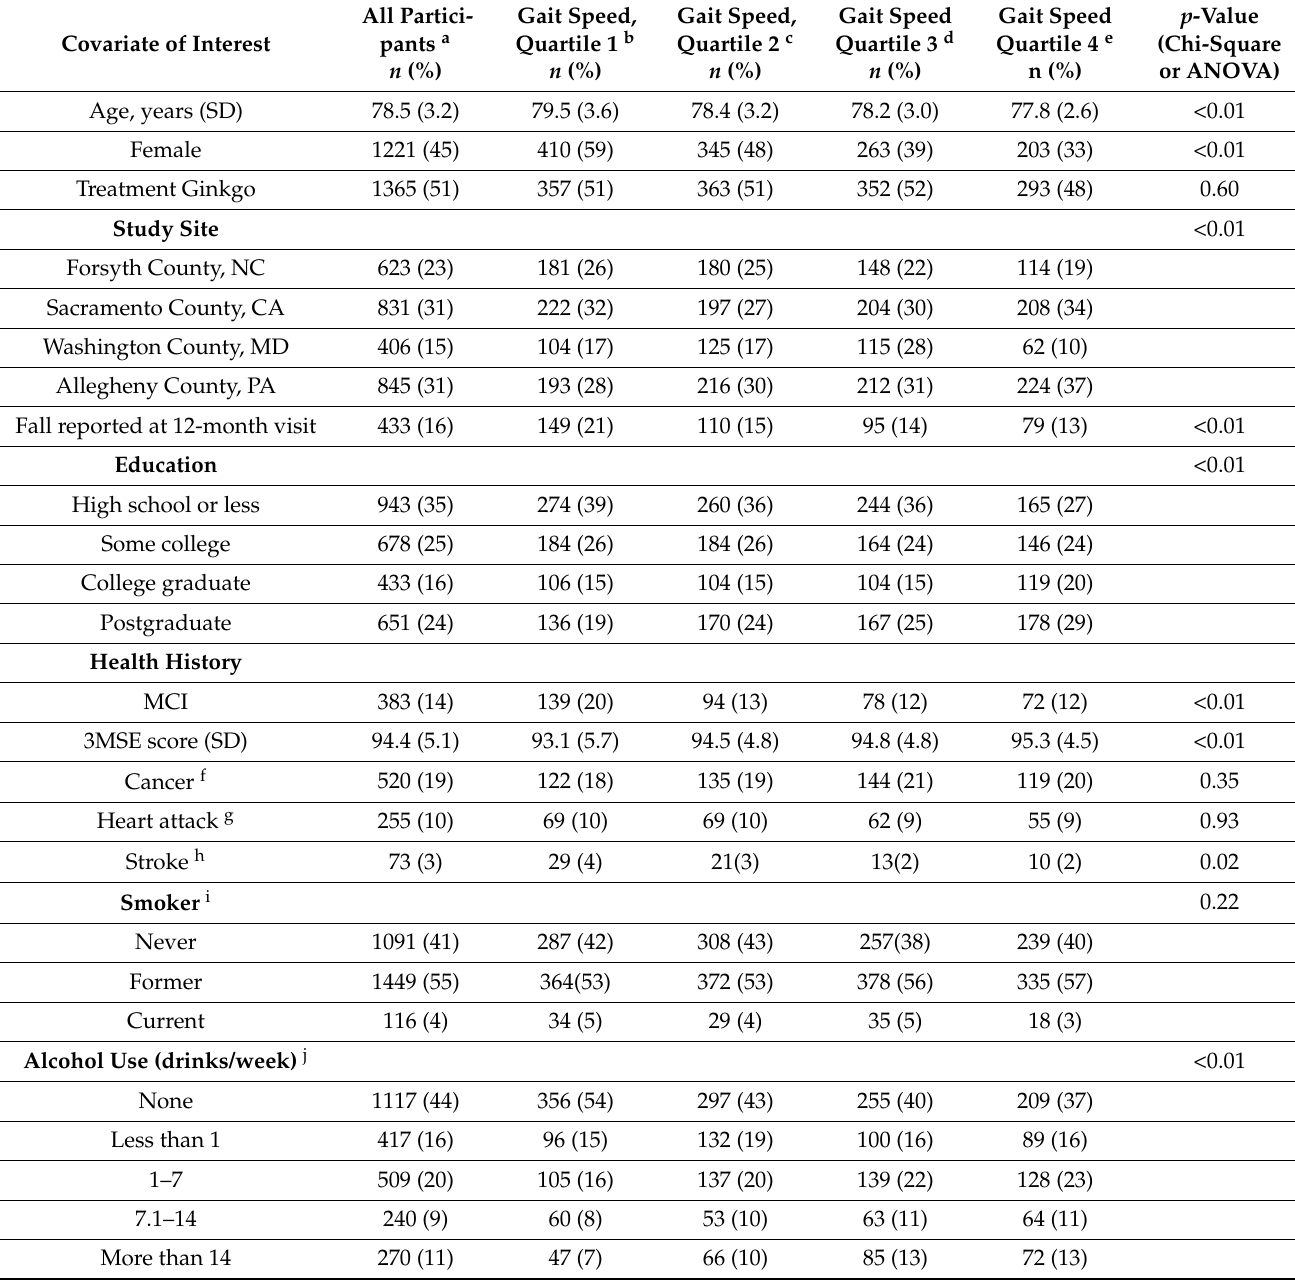
Table 1. Participant characteristics by preferred gait speed quartile at 12-month study visit, Ginkgo Evaluation of Memory study (GEMS) ( n =